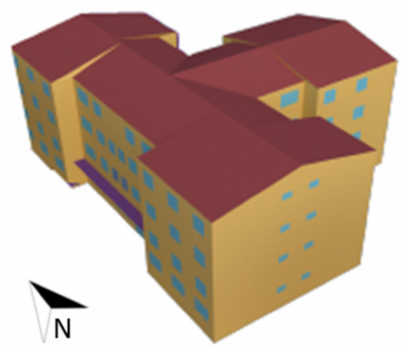
Figure 5. 3D-Geometry of the building model.